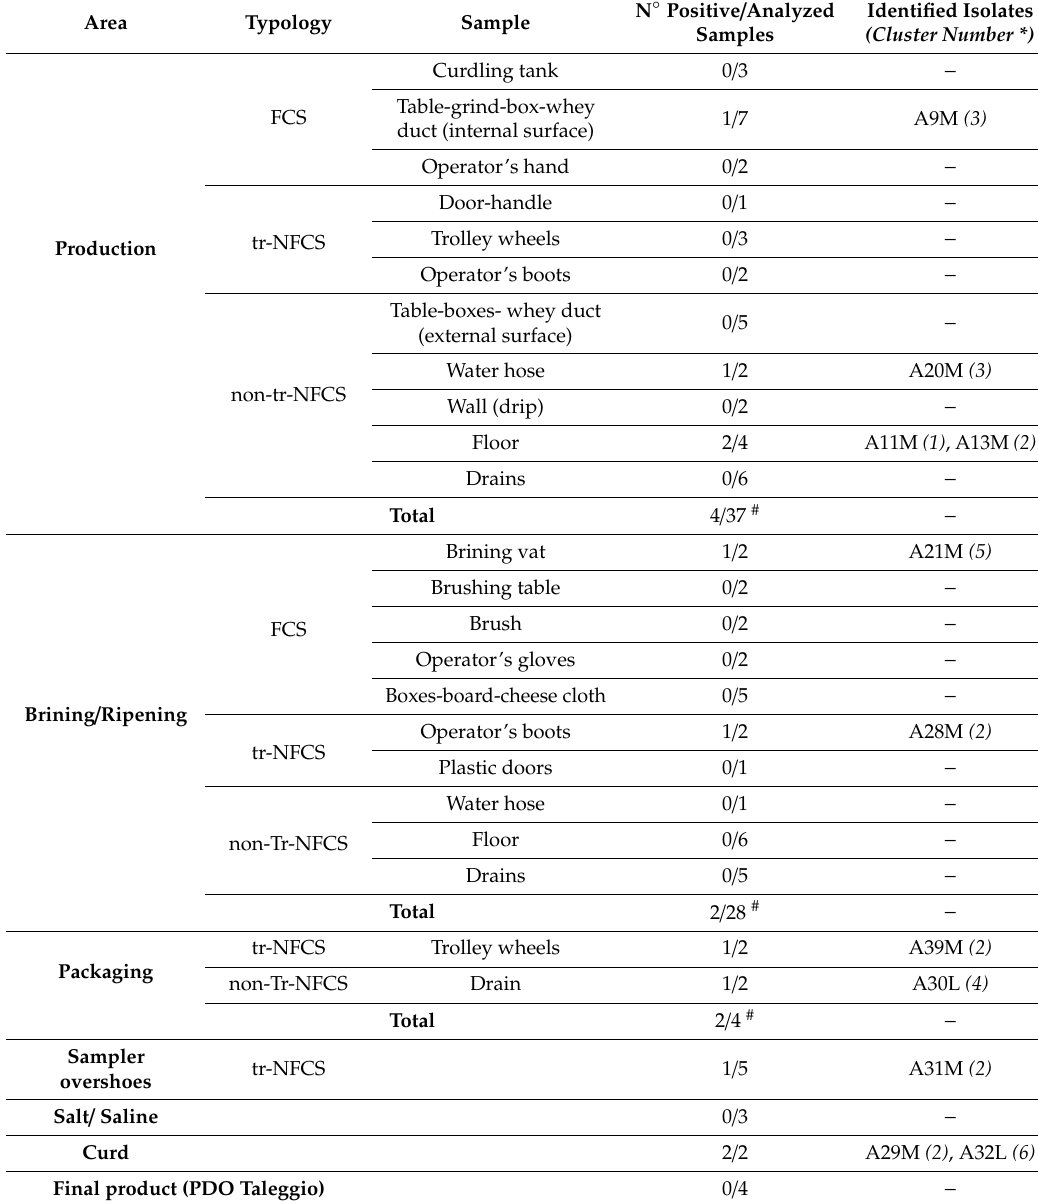
Table 1. Detection of B. cereus in di ff erent areas and sample typologies of the dairy plant. FCS: food contact surfaces; tr-NFCS: transfer-non food contact surfaces; non-tr-NFCS: non-transfer-non food contact surfaces.